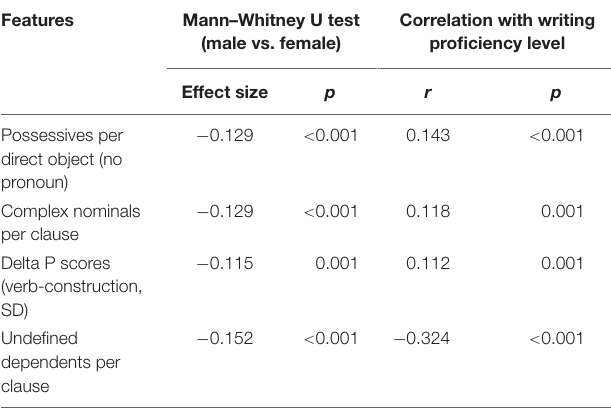
TABLE 4 | Distinctive syntactic features between the two gender groups (TAASSC).